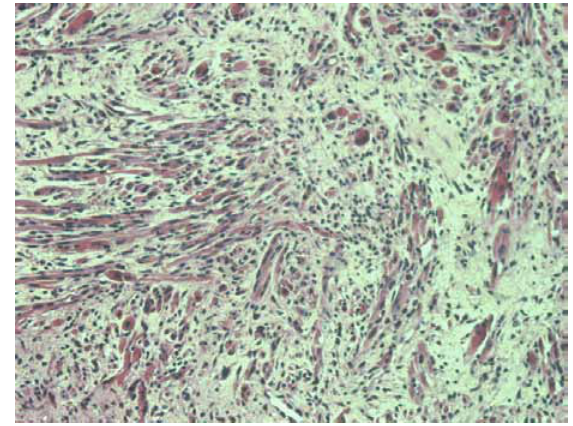
Figure 2. Typical appearance of the tumor tissue (Hematoxylin- eosin x